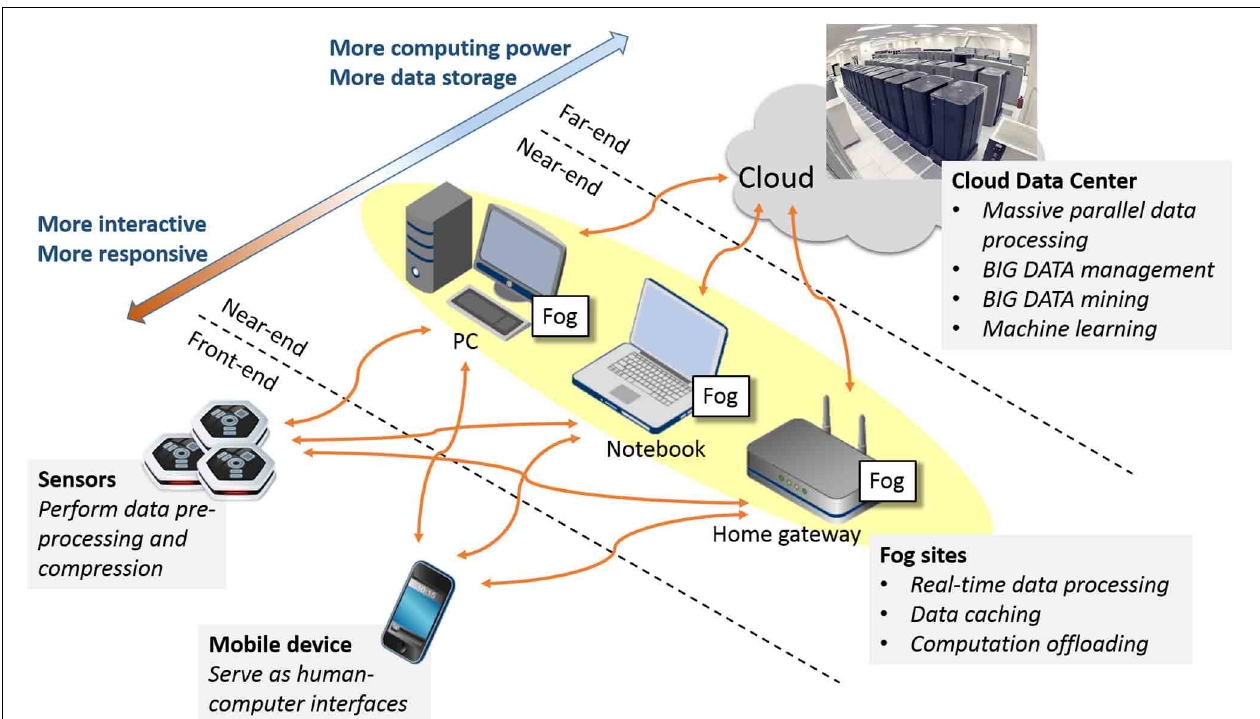
FIGURE 1 | Conceptual architecture of Fog/Cloud Computing